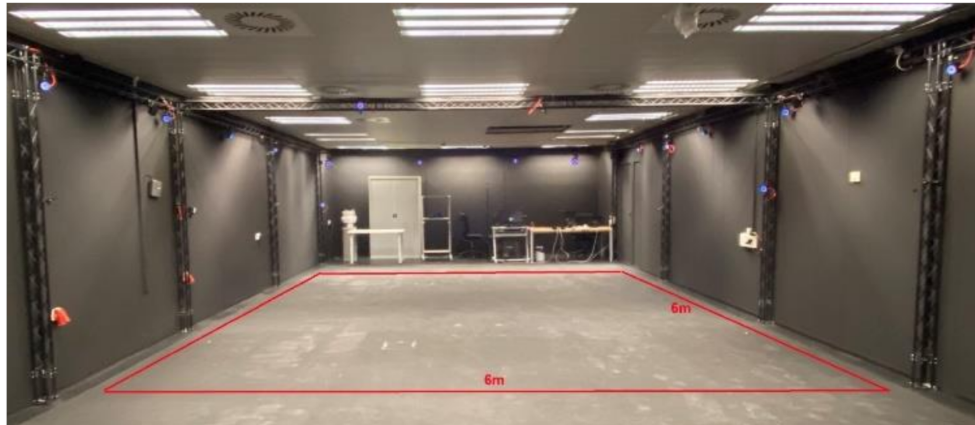
Figure 2. The 6 × 6 m 2 physical area of the virtual store for performing the experiments in the European Immersive Neurotechnology’s Laboratory (LENI) of the Polytechnic University of Valencia.